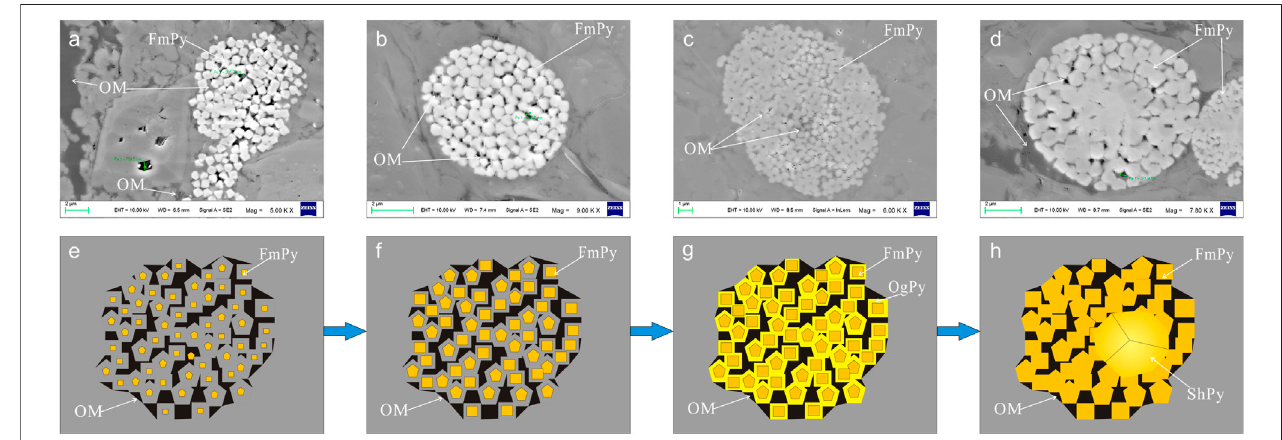
FIGURE 7 | Genetic model of framboidal pyrite in organic-rich shale. OM = organic matter; FmPy= framboidal pyrite; OgPy= pyrite overgrowth; ShPy = subhedral pyrite.